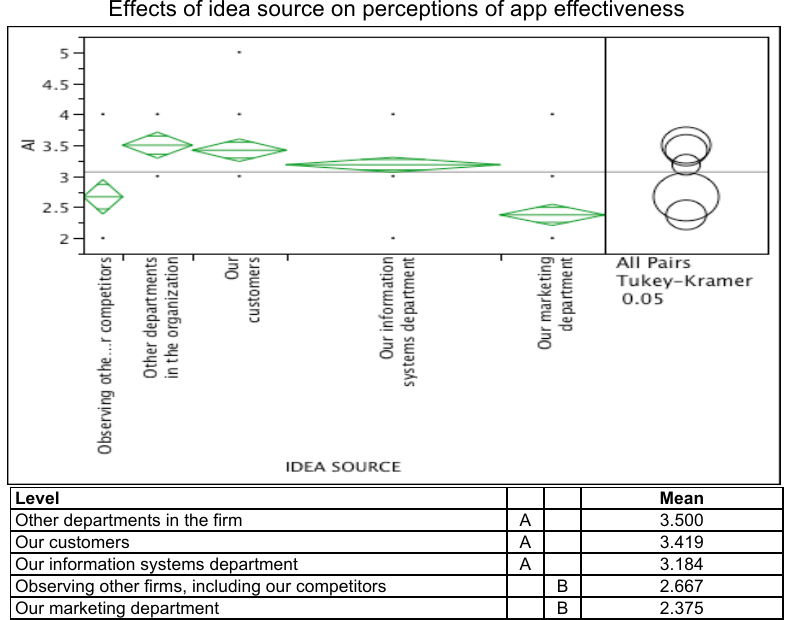
Effects of idea source on perceptions of app effectiveness